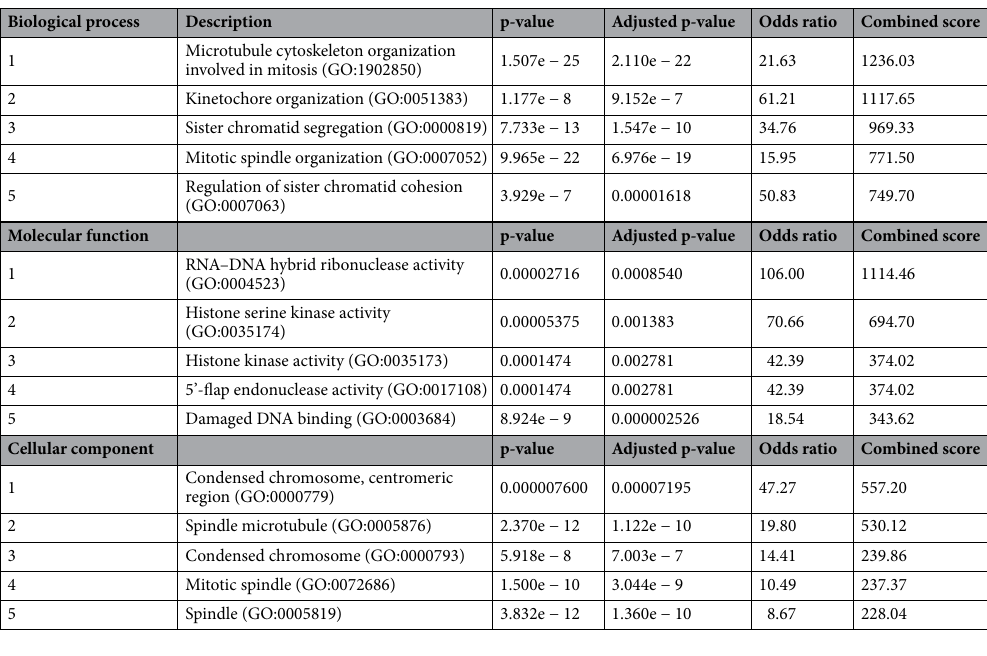
Table 7. Gene ontology biological process, molecular function, and cellular component-based enrichment analysis of up-regulated